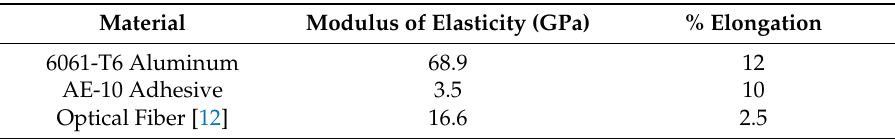
Table 1. Mechanical Properties of Aluminum, Adhesive and Optical